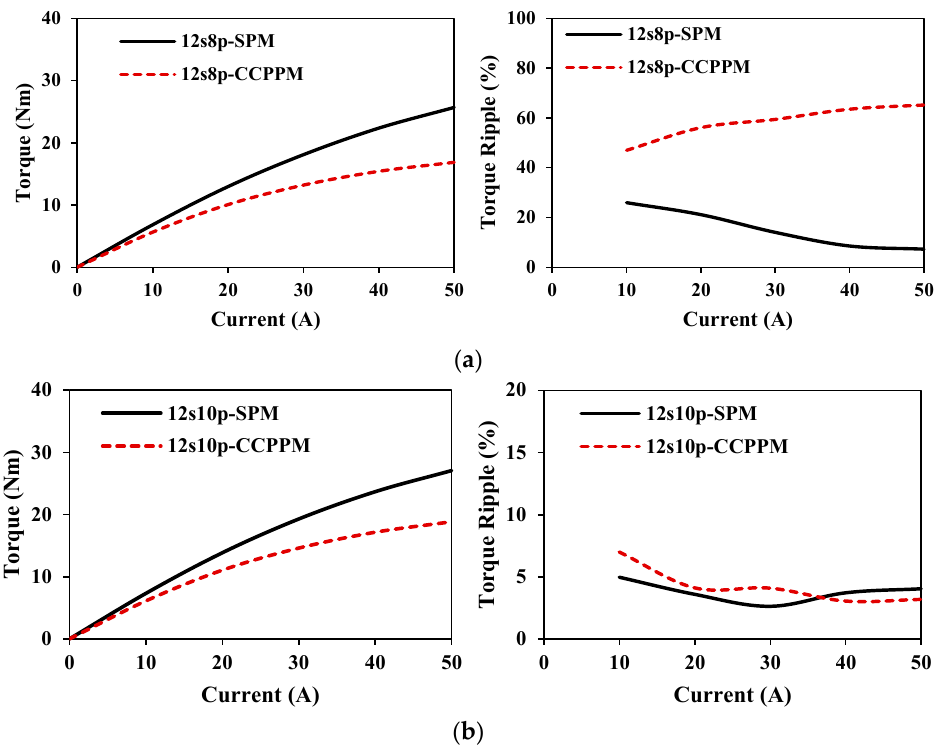
Figure 20. Average torques and torque ripples for SPM and CCPPM machines. ( a ) 12s8p machines. ( b ) 12s10p machines.